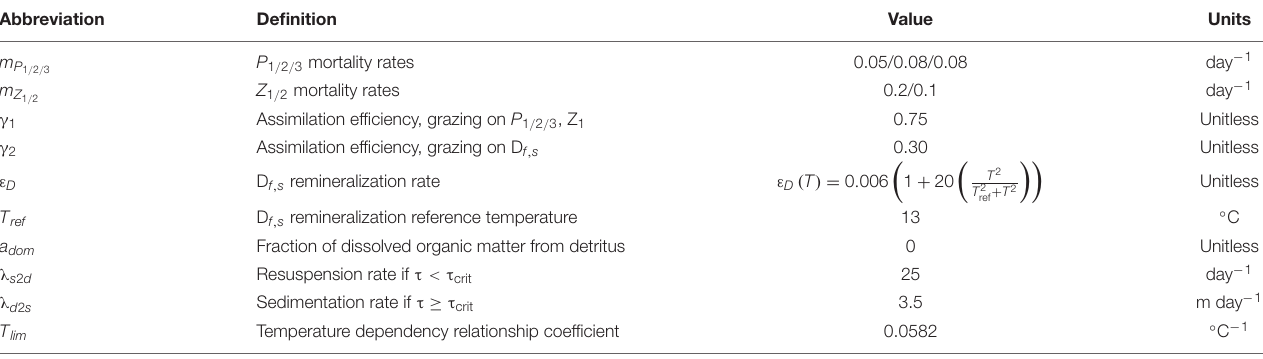
TABLE 3 | List of parameters, corresponding description, and units used in the model for pelagic dynamic.